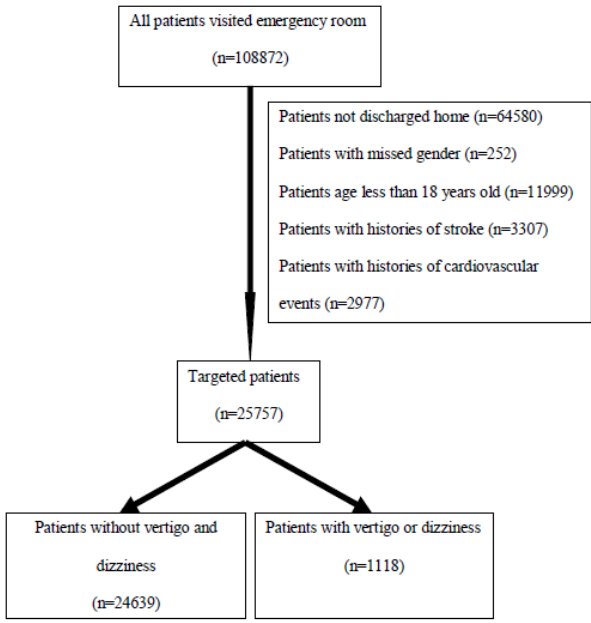
Figure 1. Flow diagram of the population-based study.